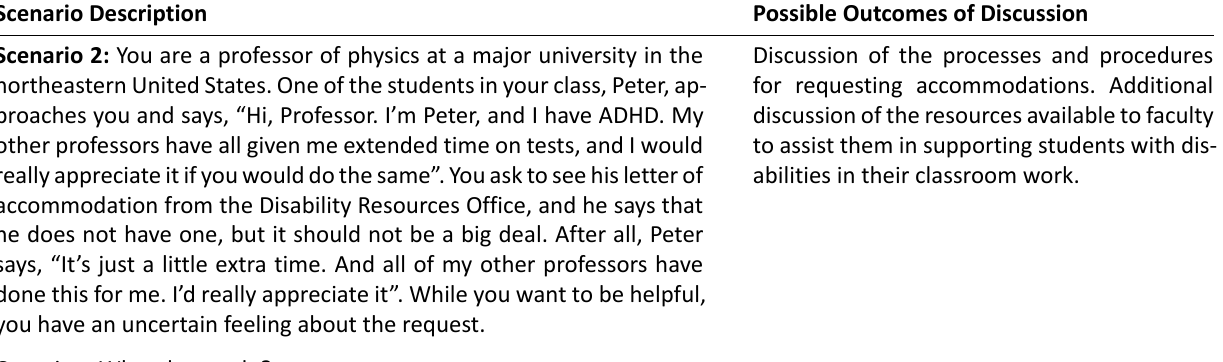
Table 1. (Cont.) Examples of